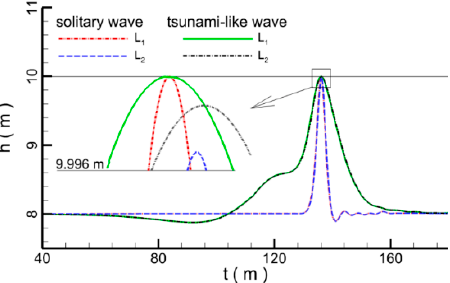
Figure 14. Time series of water elevations recorded at elevation sensors L1 and L2 for the solitary and tsunami-like wave.